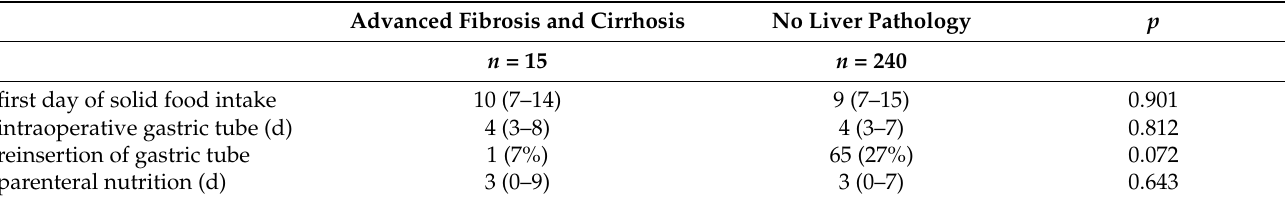
Table 3. Delayed gastric emptying (DGE) parameters according to ISGPS.